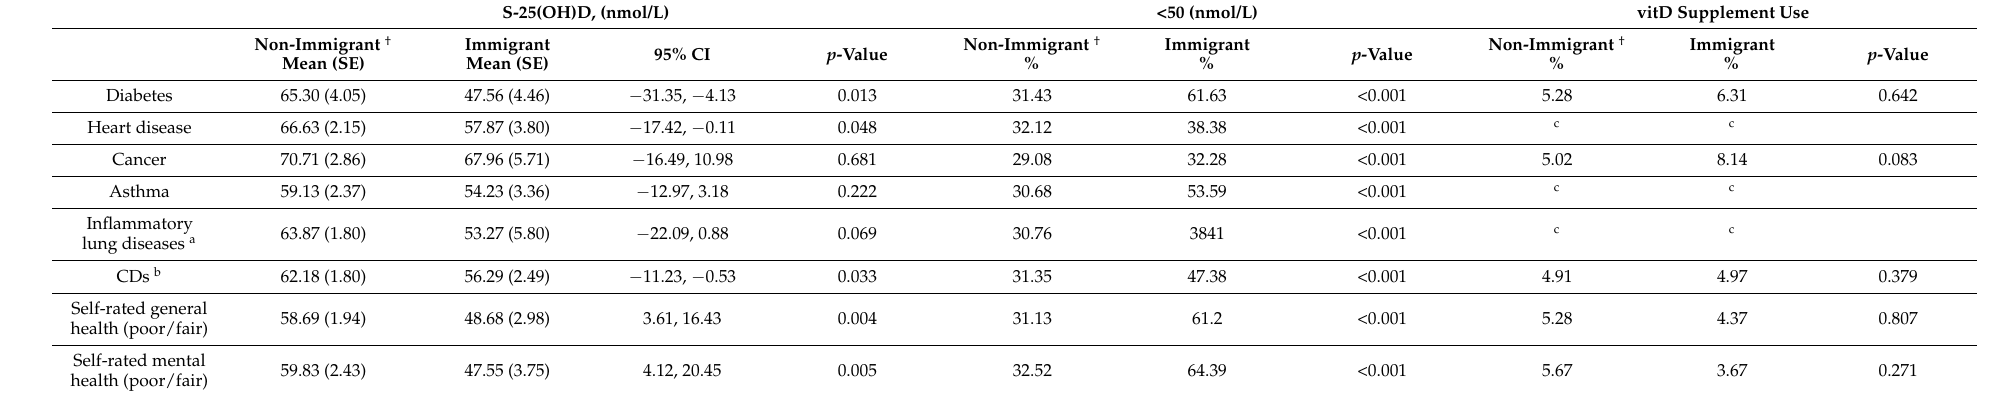
Table 3. Weighted mean 25(OH)D (nmol/L), prevalence of vitD insufficiency (<50 nmol/L), and vitD supplement use by immigration